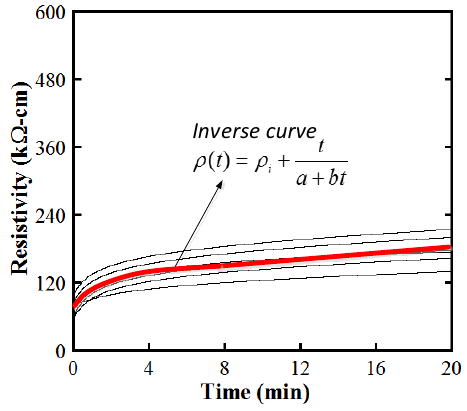
Figure 10. Suggested fitting curve for the polarization behavior of